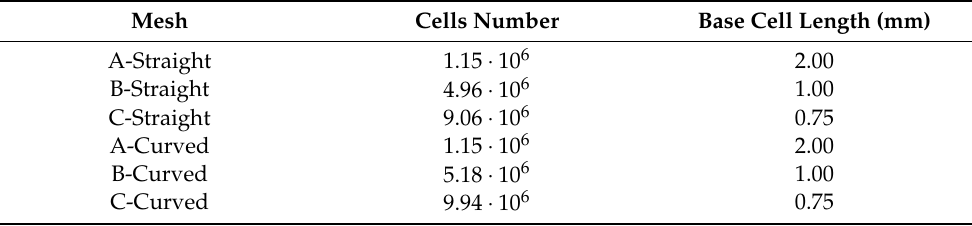
Table 2. Fluid computational domains